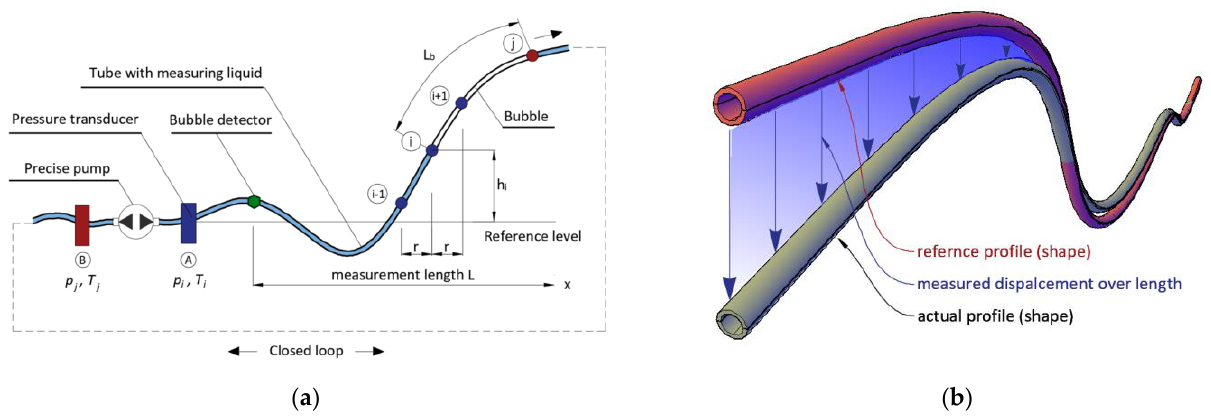
Figure 4. ( a ) Scheme of the new hydraulic system with closed loop; ( b ) principle of determining vertical displacements from measured profiles in subsequent measurement sessions.